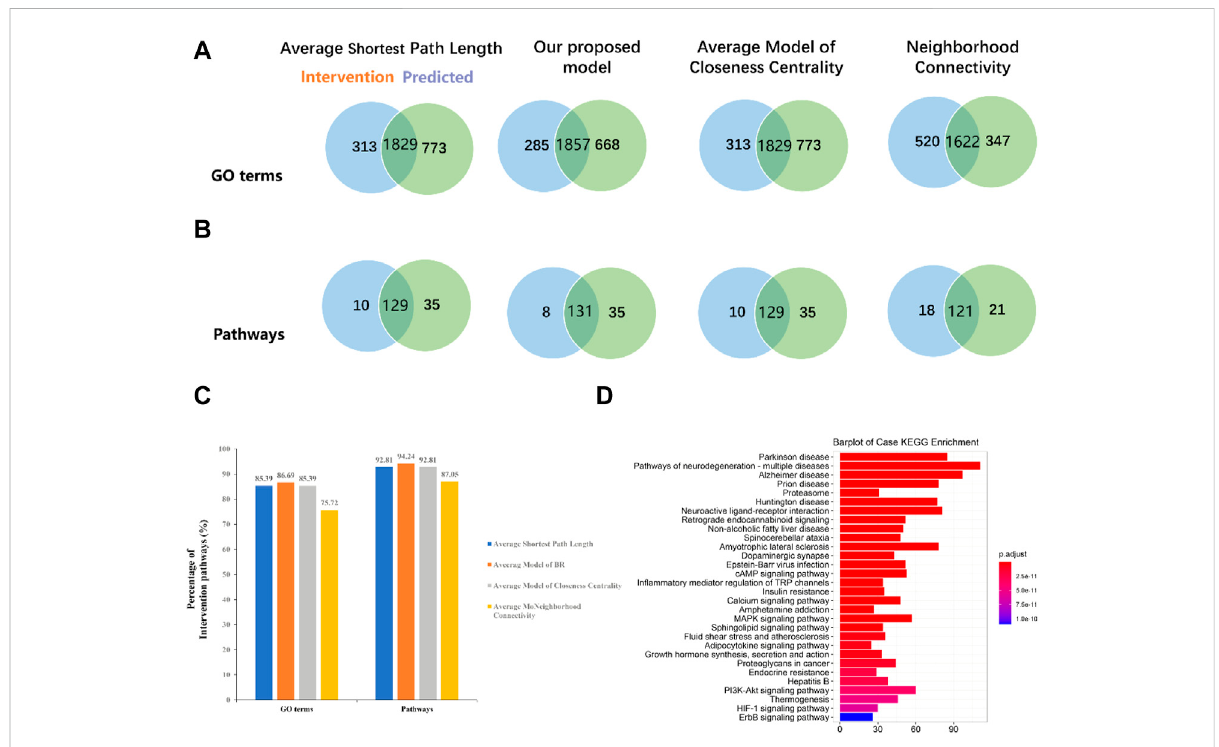
FIGURE 5 Compared our proposed model with other widely used models. (A) Venn diagrams display overlapping GO terms of four models with intervention GO terms. (B) Venn diagrams display overlapping pathways of four models with intervention pathways. (C) Comparison of our model with other models on the intervention pathways and GO terms. (D) Bar plot for effective proteins ’ pathway enrichment